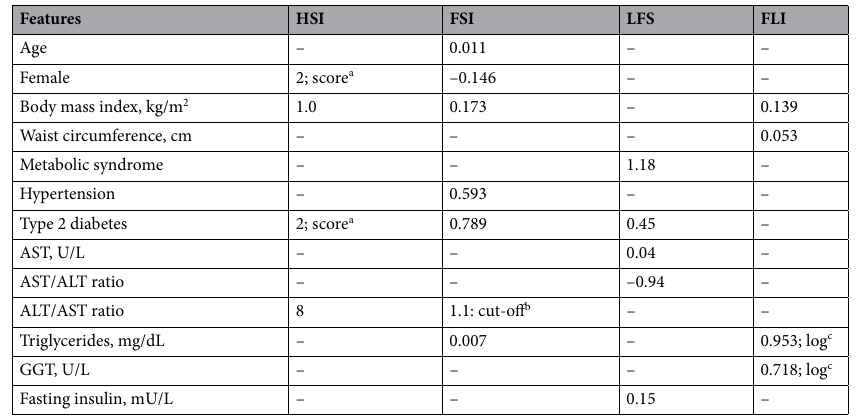
Table 2. Features and their coefficients in the NAFLD scoring models. a If a subject satisfies the criteria, just adding the score of 2. b If a subject has ALT/AST ratio ≥ 1.1, just adding the score of 1. c The variable is used after log-transformation. HSI hepatic steatosis index, FSI Framingham steatosis index, LFS NAFLD liver fat score , FLI fatty liver index, AST aspartate aminotransferase, ALT alanine aminotransferase, GGT gamma-glutamyl